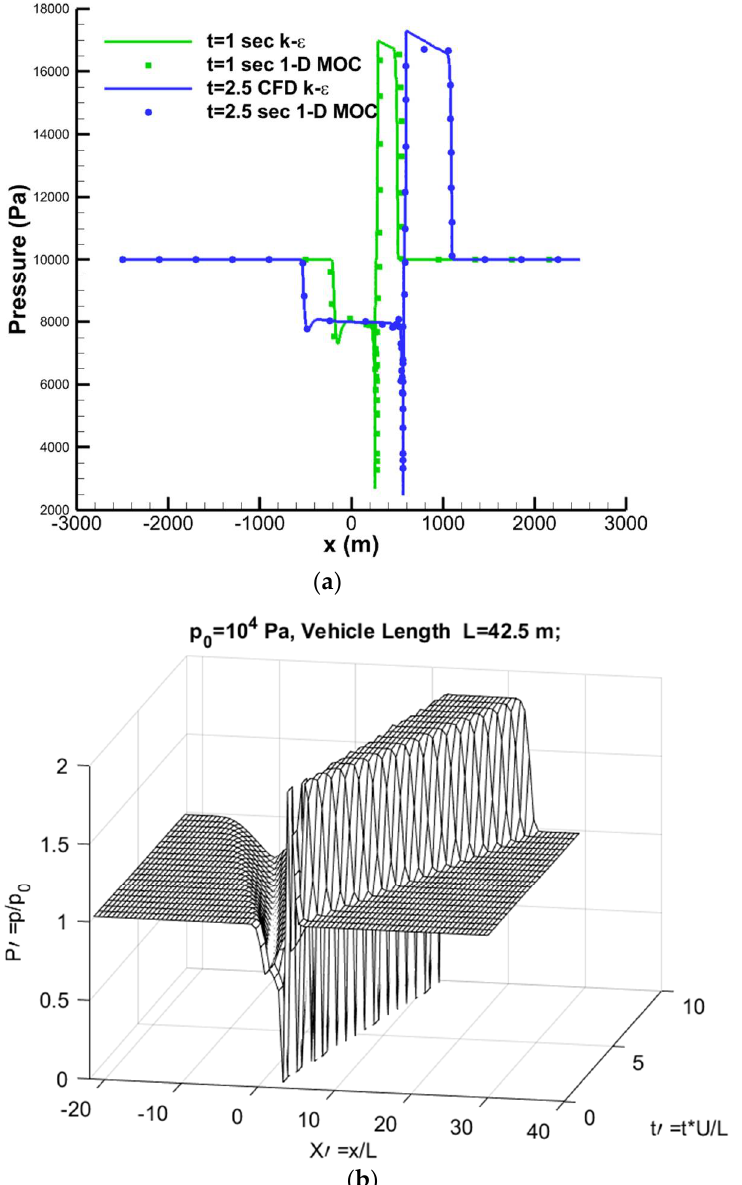
Figure 12. Pressure wave propagation ( a ) along x-coordinates at t = 1, 2.5 s; ( b ) wave propagation in x-space and time, (cid:2010) = 0.56 . Table 3. Comparison of computational time for 1-sec travel time.